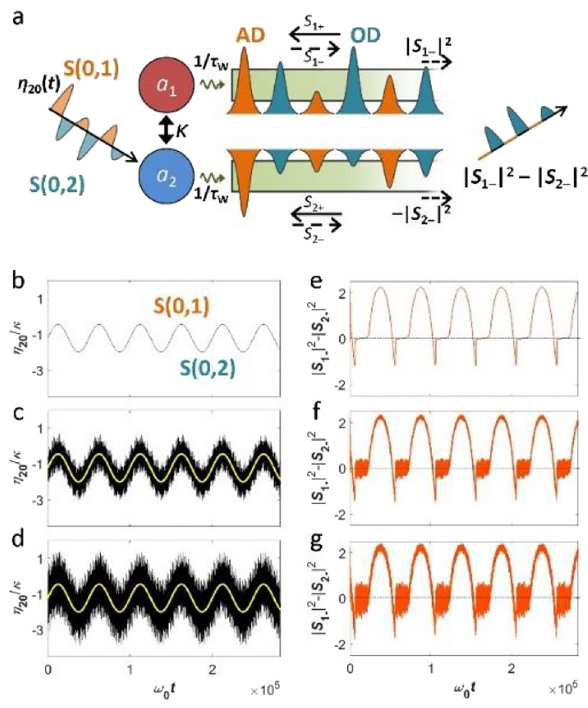
Figure 5: Noise-immune laser rectification. (a) Operation principles of the rectifications: AD in the S(0,1) phase and OD in the S(0,2) phase. (b – g) Noise-suppressed laser rectifi- cations: (b – d) κ -normalized modulation signals η 20 ( t ) with different noise levels and (e – g) output signals | S 1 − | 2 − | S 2 − | 2 . The signal